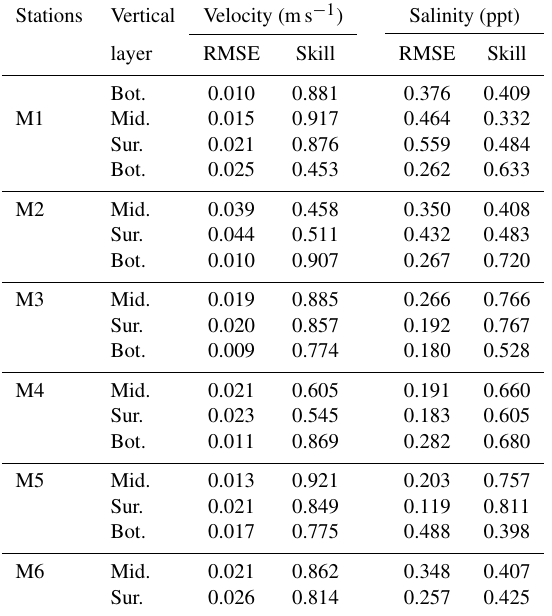
Table 3. Comparison between model results and observation in De- cember